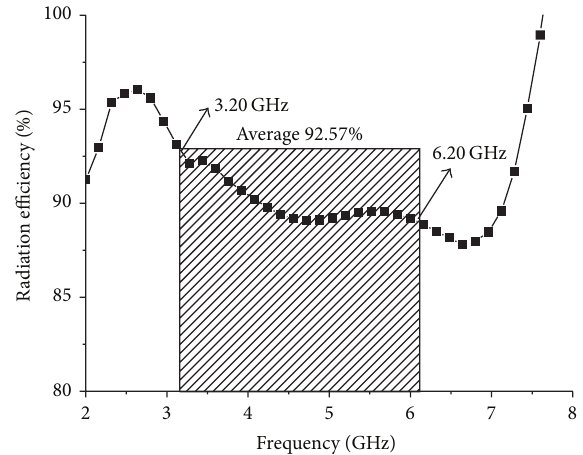
Figure 13: Radiation efficiency of the proposed antenna.